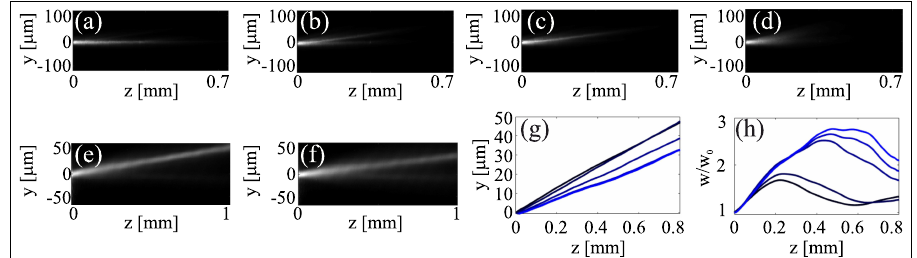
Figure 7. Competing nonlinearities in DDNLC. ( a – c ) Acquired images of green beam evolution for various linear input polarizations and P g = 6 mW, in the presence of a P i = 4 mW NIR nematicon. ( a ) In the ordinary polarization, the visible beam self-confines and does not sense the extraordinary-wave nematicon waveguide. ( b ) When polarized at 45 ◦ the ordinary component is less confined (owing to reduced power) while the extraordinary component gets confined within the nematicon, as in the case ( c ) of both co-polarized extraordinary-wave beams. ( d ) The P g = 6 mW extraordinary-wave green without NIR undergoes self-defocusing. ( e , f ) Acquired images of the NIR nematicon ( P i = 4 mW) interacting with a collinear co-polarized green beam for ( e ) P g = 1 mW and ( f ) P g = 6 mW. NIR beam ( g ) trajectories and ( h ) width evolutions when varying the green power from 0 to 6 mW (darker to lighter lines),